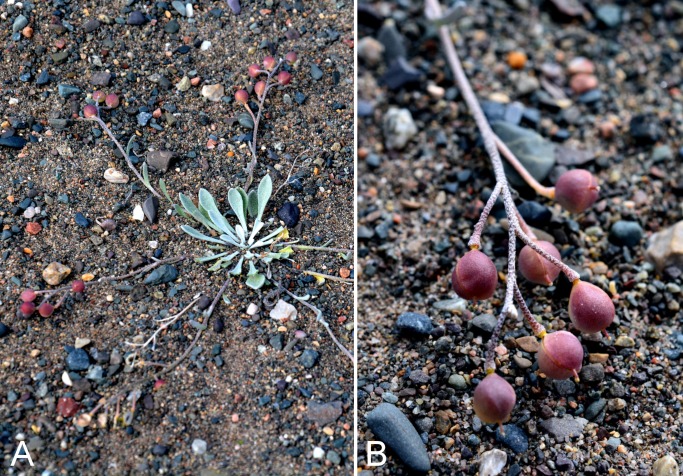
Physaria arctica.(A) Habit, Saarela et al. 4177. (B) Fruits, Saarela et al. 4177. Photographs by P. C. Sokoloff.